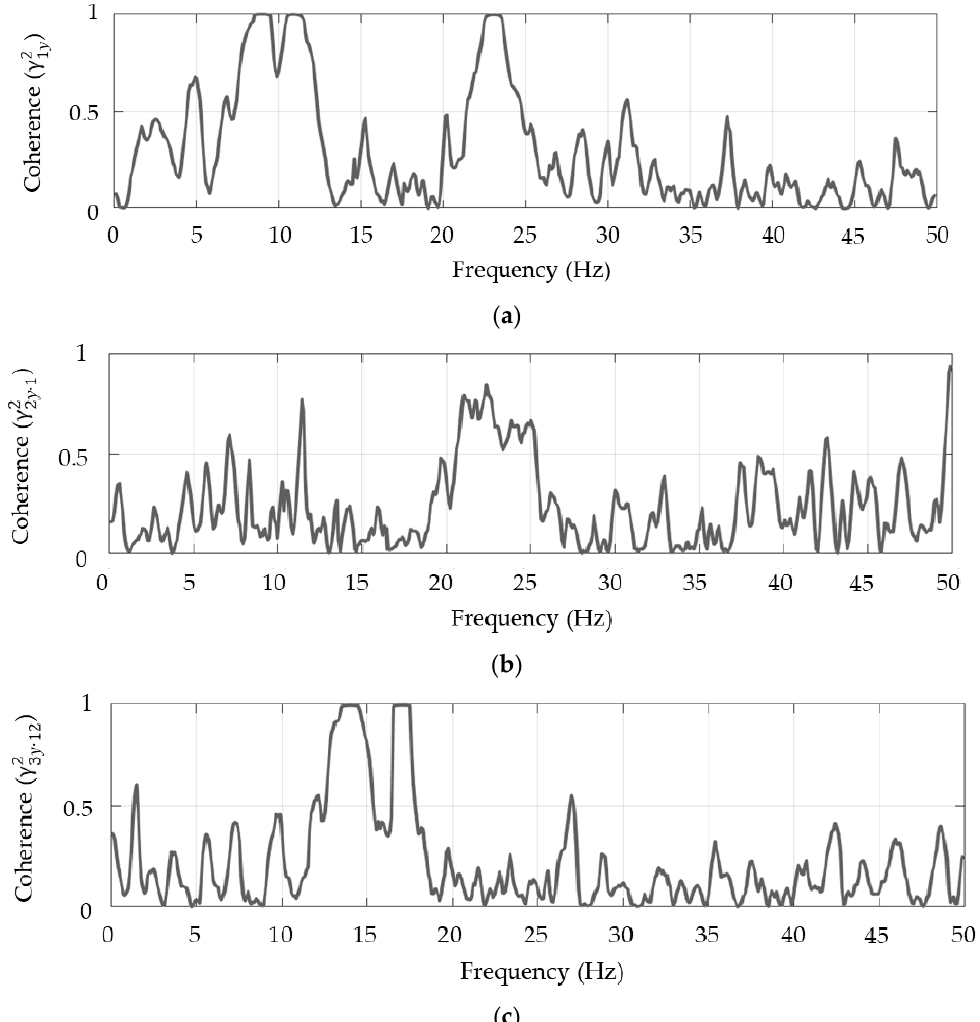
Appl. Sci. 2020 , 10 , 7027